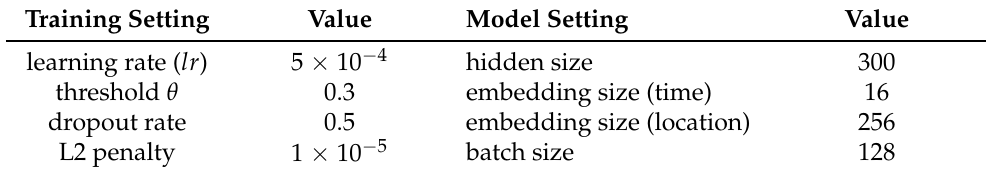
Table 4. Experimental settings of calibration